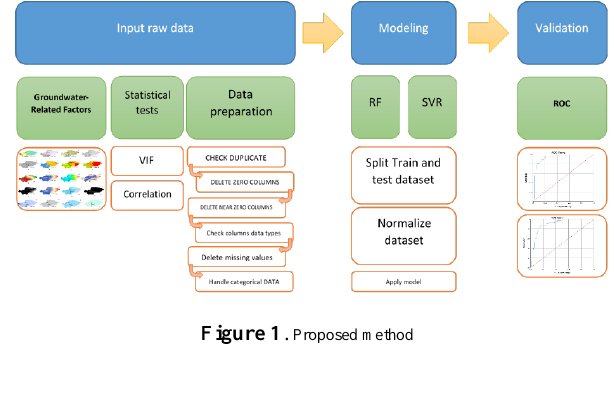
Figure 1 . Proposed